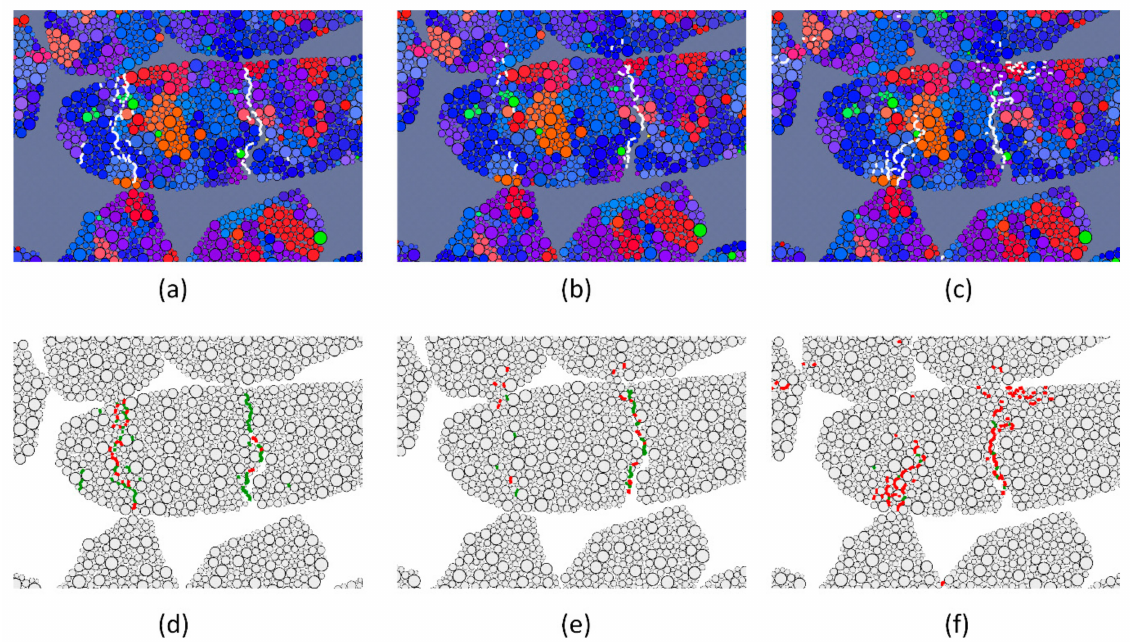
Figure 15. Image sections of the simulations with high resolution showing the effect of the grain boundary factor z Boundary on the breakage pattern: z Boundary = 0.6 ( a , d ); z Boundary factor = 1.0 ( b , e ); z Boundary = 1.4 ( c , f ). The images in the first row ( a – c ) show the influence of the mineral microstructure on the breakage pattern (white lines). In the images of the second row ( d – f ) the focus is on the crack type (green lines: intergranular cracks; red lines: intragranular cracks).